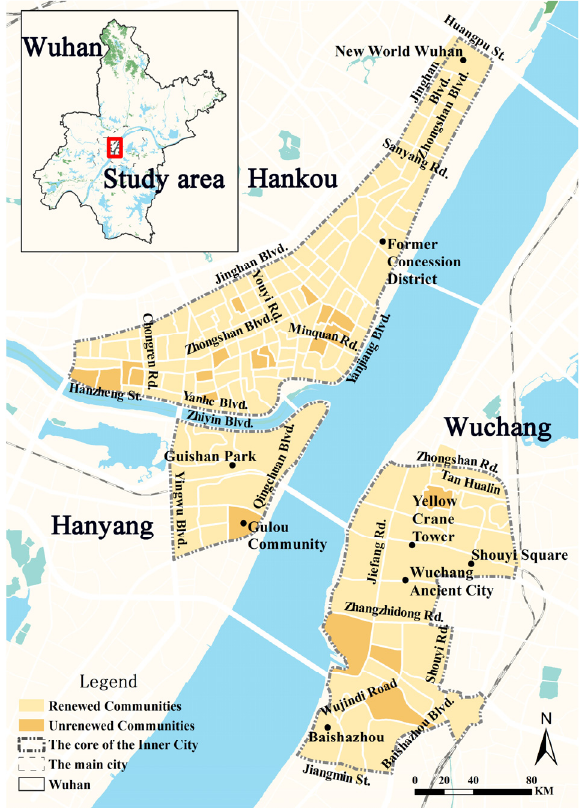
Figure 2. The core area of the inner city of Wuhan.